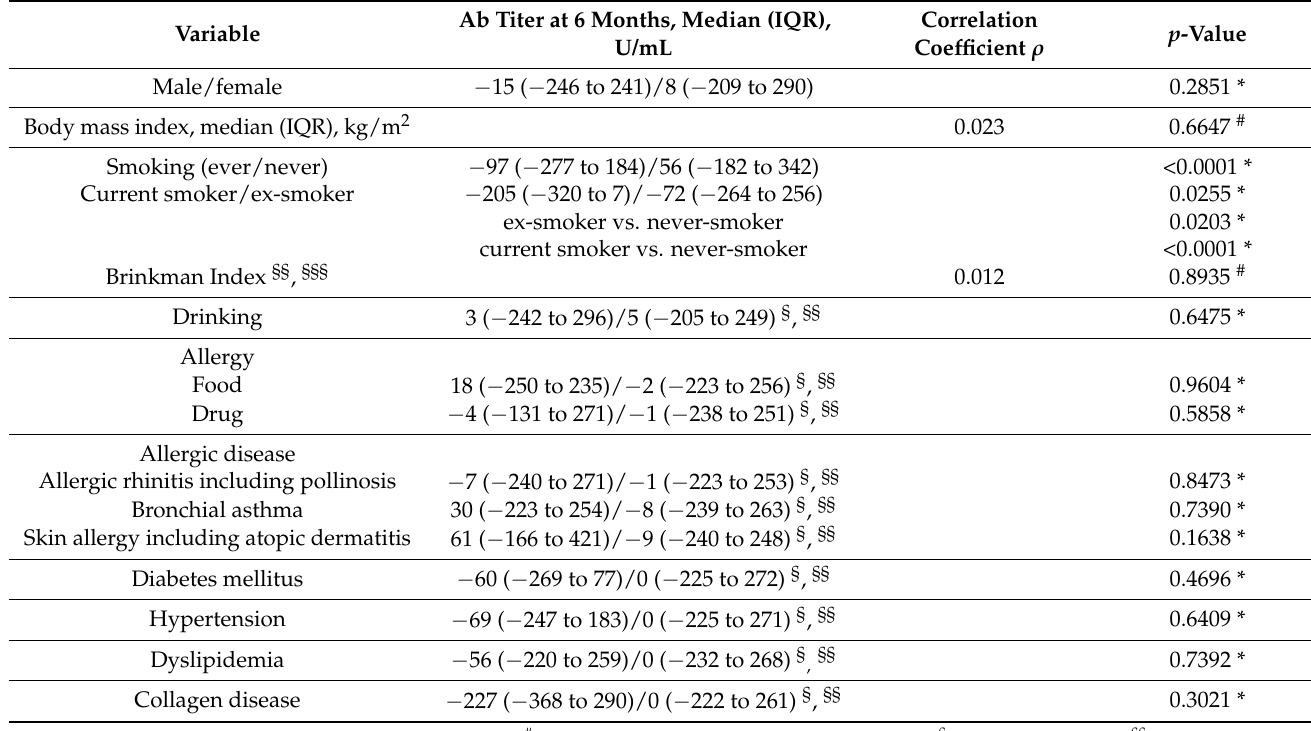
Table 2. Age-adjusted data of median Ab titers ( N =